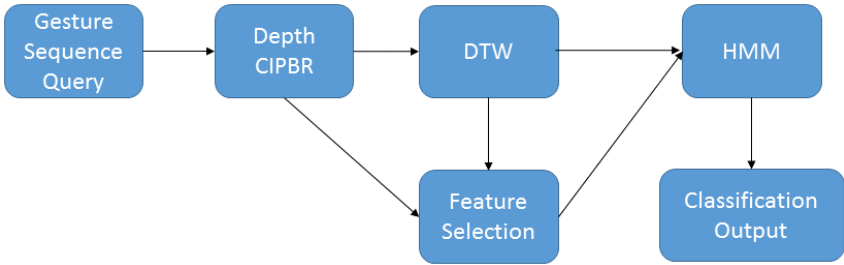
Figure 4. HAGR-D classification